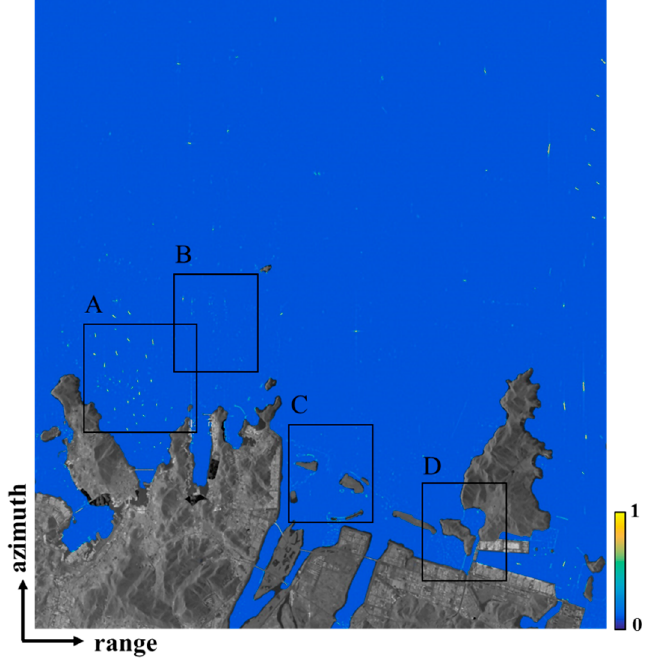
Figure 5. Ship-probability map obtained by using the ANN approach. The boxes A to D are used for the detailed analysis.